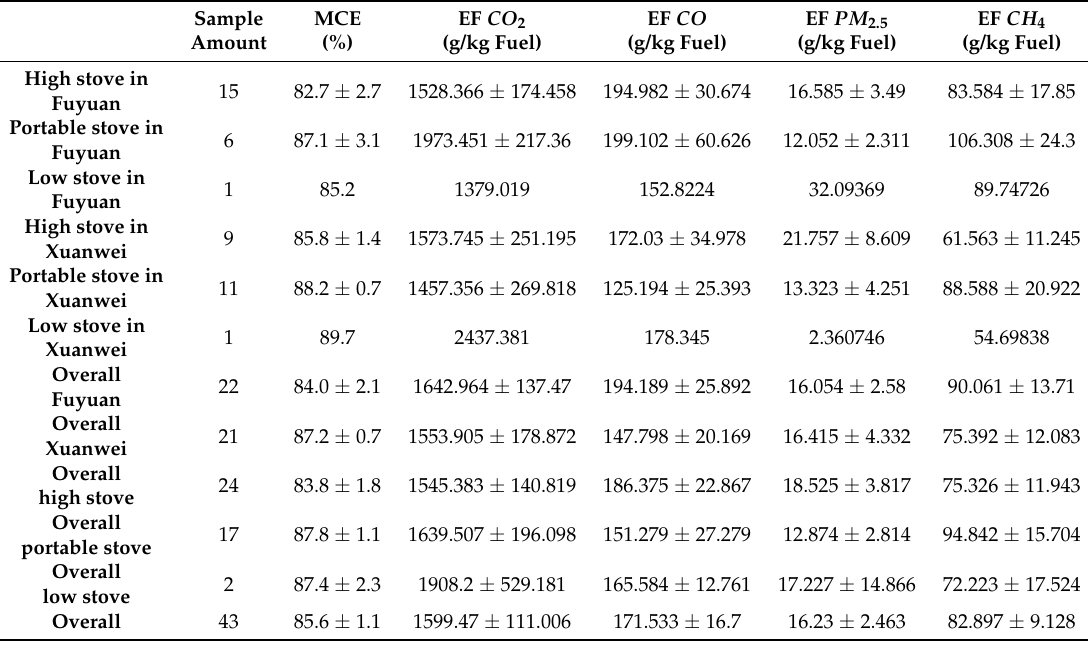
Table 4. Statistical summary for the Yunnan measurement.